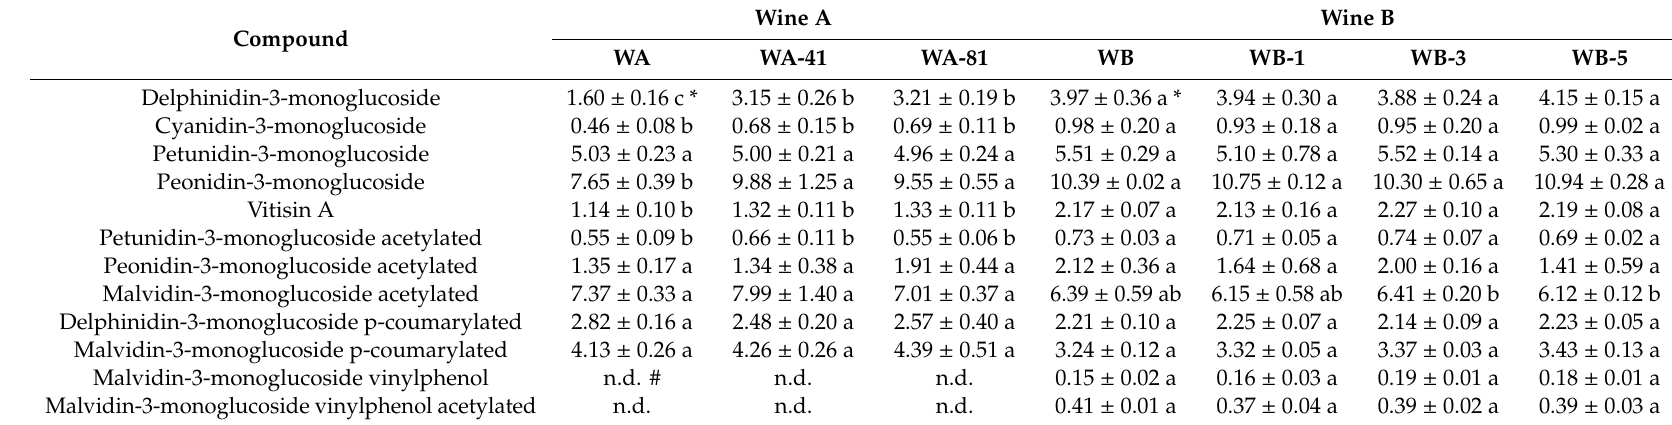
* Each datum represents the mean of three replicates ± standard deviation. Values with di ff erent letters within line indicate significative di ff erences ( p < 0.05). # n.d. = not